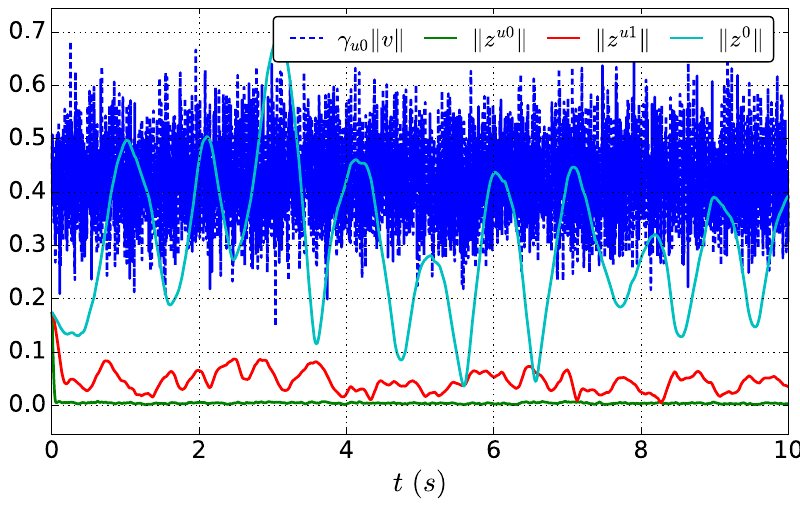
Figure 7. Norms for H ∞ bound γ u 0 || v || and controlled output z .